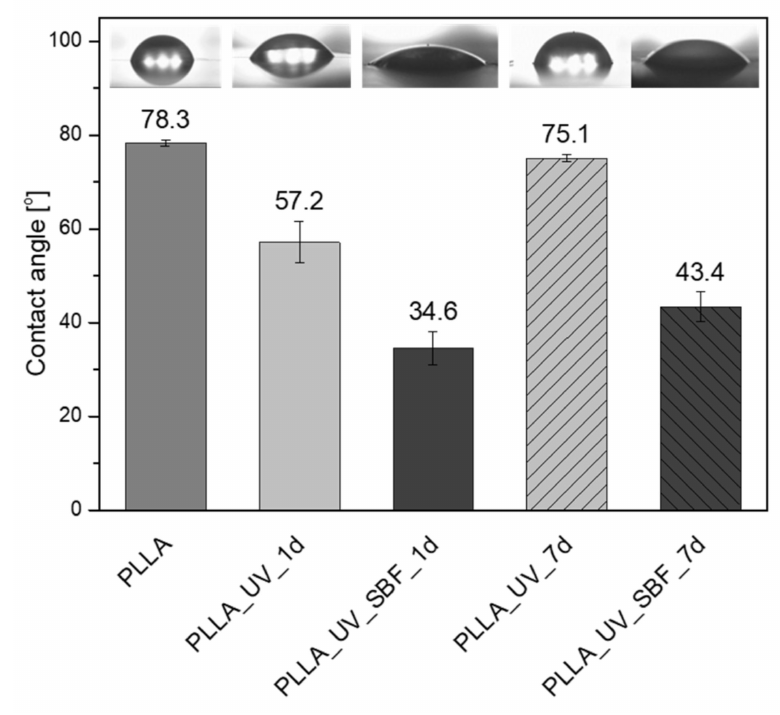
Figure 3. Contact angle measurements on modified